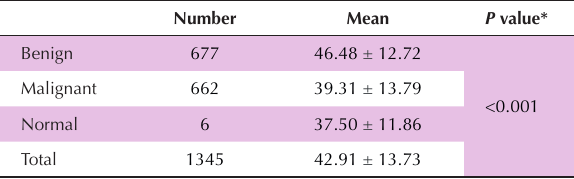
Table 2. Descriptive indicators of patients’ age by cancer